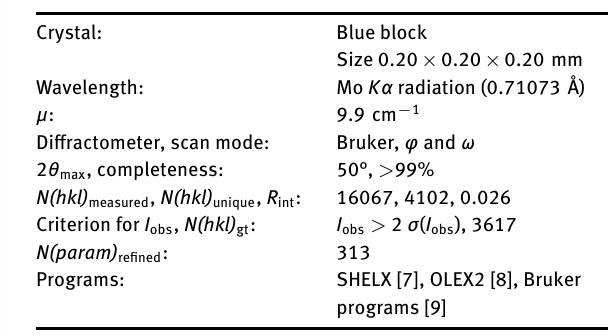
Table 1: Data collection and handling.